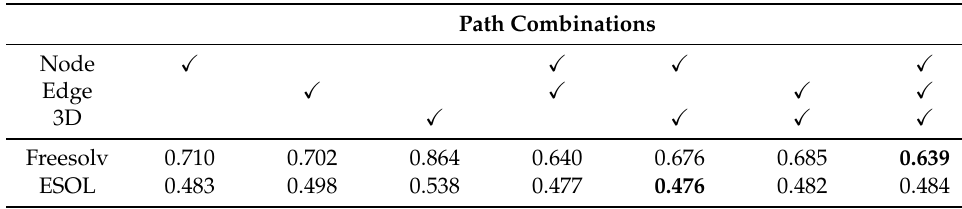
Table 5. Average of MAE for path